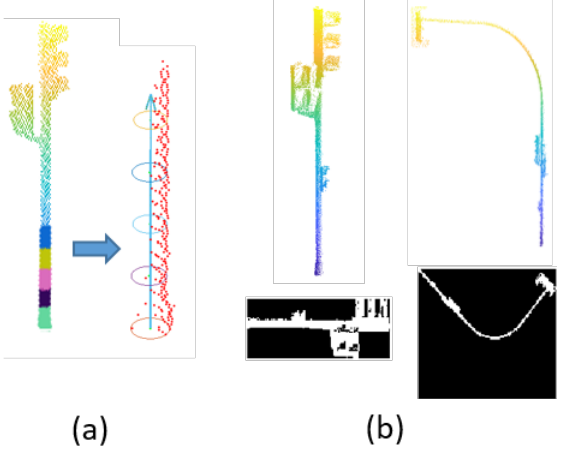
Figure 4. Traffic light classification. (a) Pole-like object segmentation. A number of sections are studied for each object, fitting circles to each one of them. (b) The objects are projected into a plane defined by their two principal components, and a binary image is defined from that